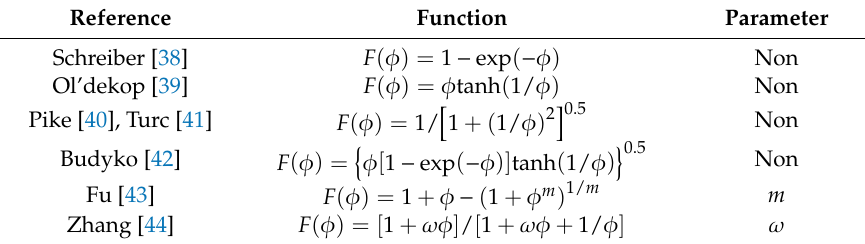
Table 1. Functions for the Budyko hypothesis used in this